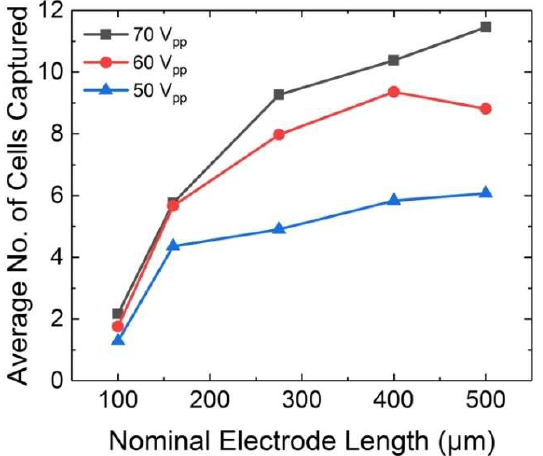
Figure 6. Plot of average cell cluster size at each BPE length (over two replicates) at ∆ U tot = 50, 60, 70 V pp (70 kHz) and 500 nL / min obtained at t = 5 min after initiation of driving voltage.